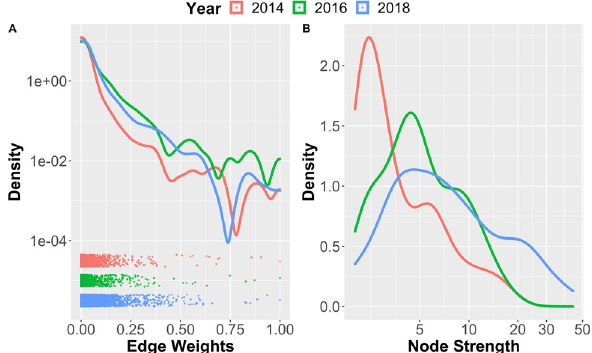
Figure 1. Densities of edge weights ( A ) and of node strengths ( B ) in the EBA financial networks of 2014, 2016 and